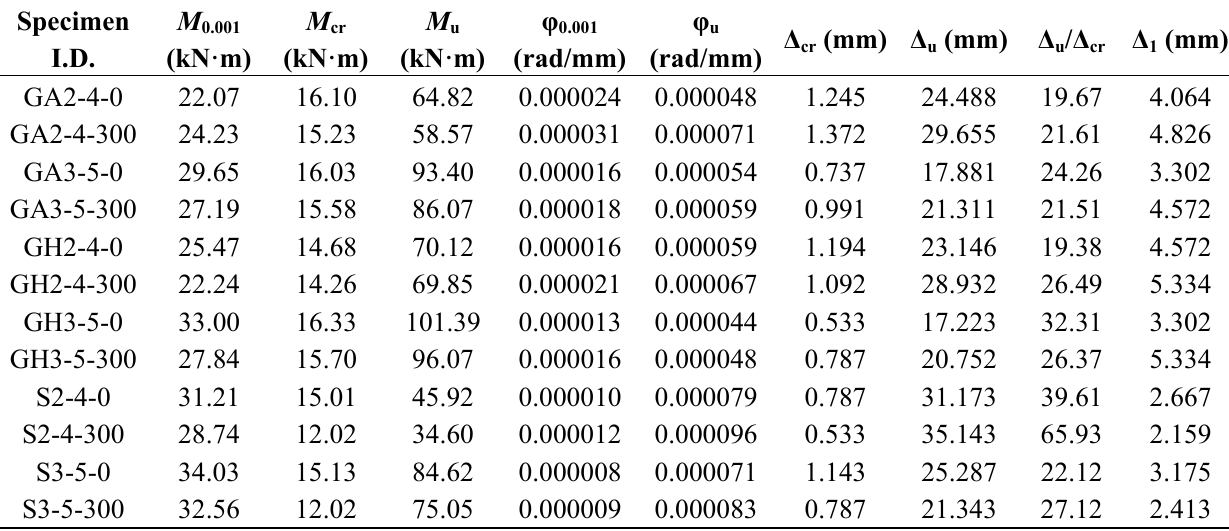
Table 6. Experimental bending moments, displacements and curvatures of specimens at cracking, service and ultimate stages for estimating the ductility indices in Table